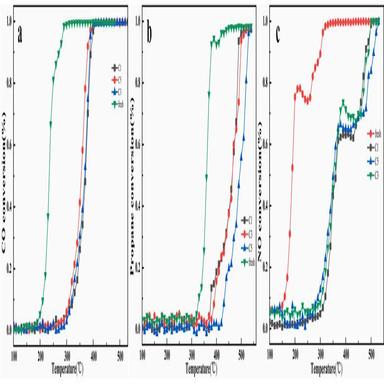
Catalytic activity of fresh and aged catalysts for CO oxidation (a), C3H8 oxidation (b) and NO conversion (c).